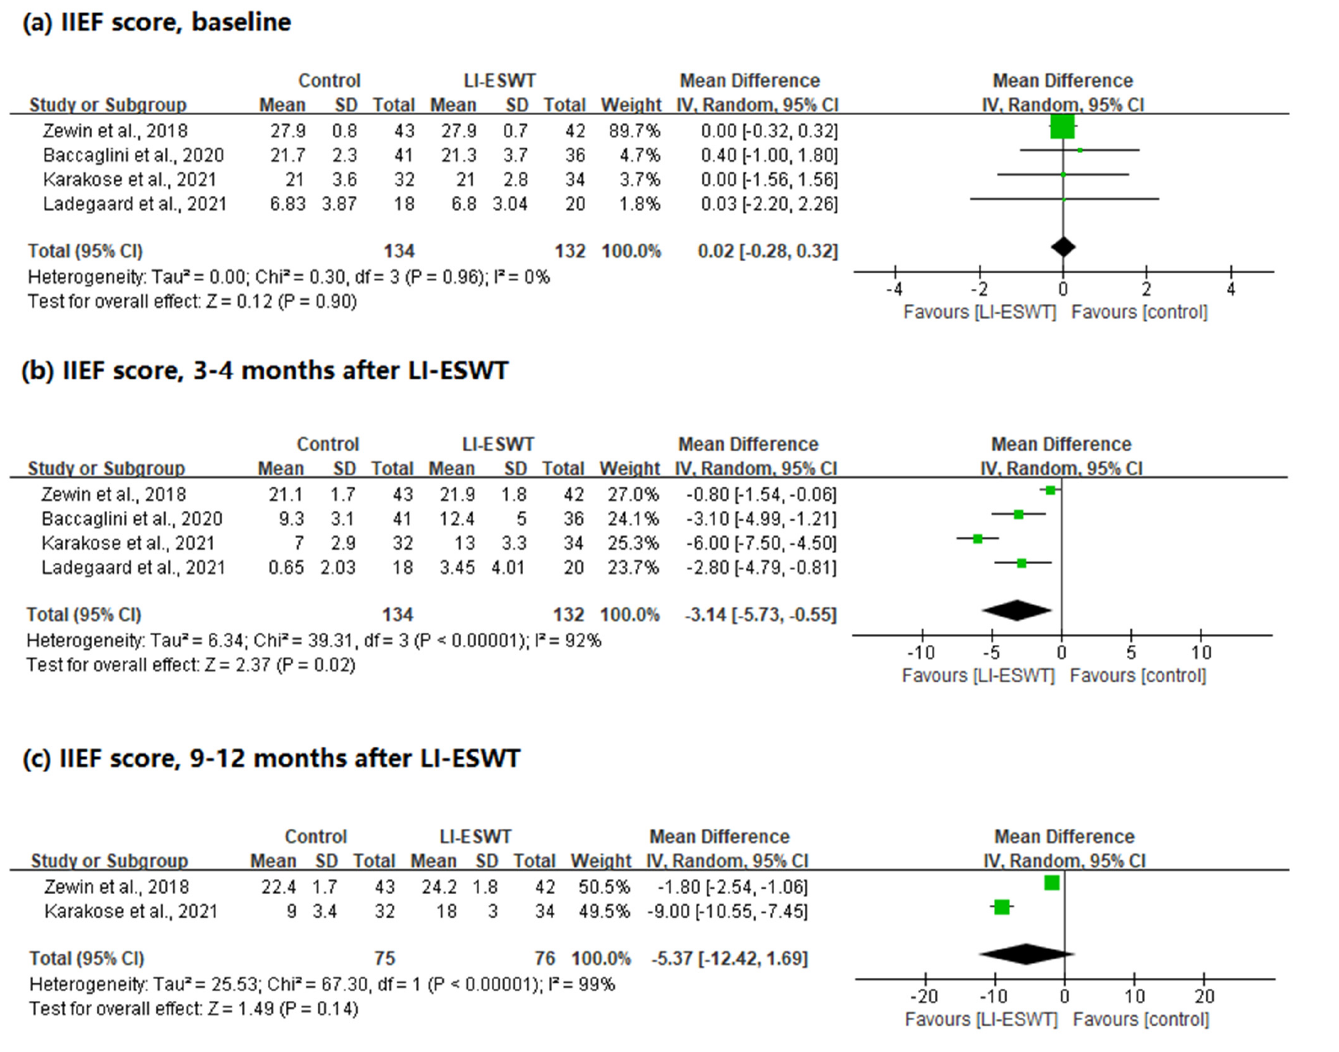
Figure 3. Forest plots for the change in IIEF scores after LI-ESWT (total studies).